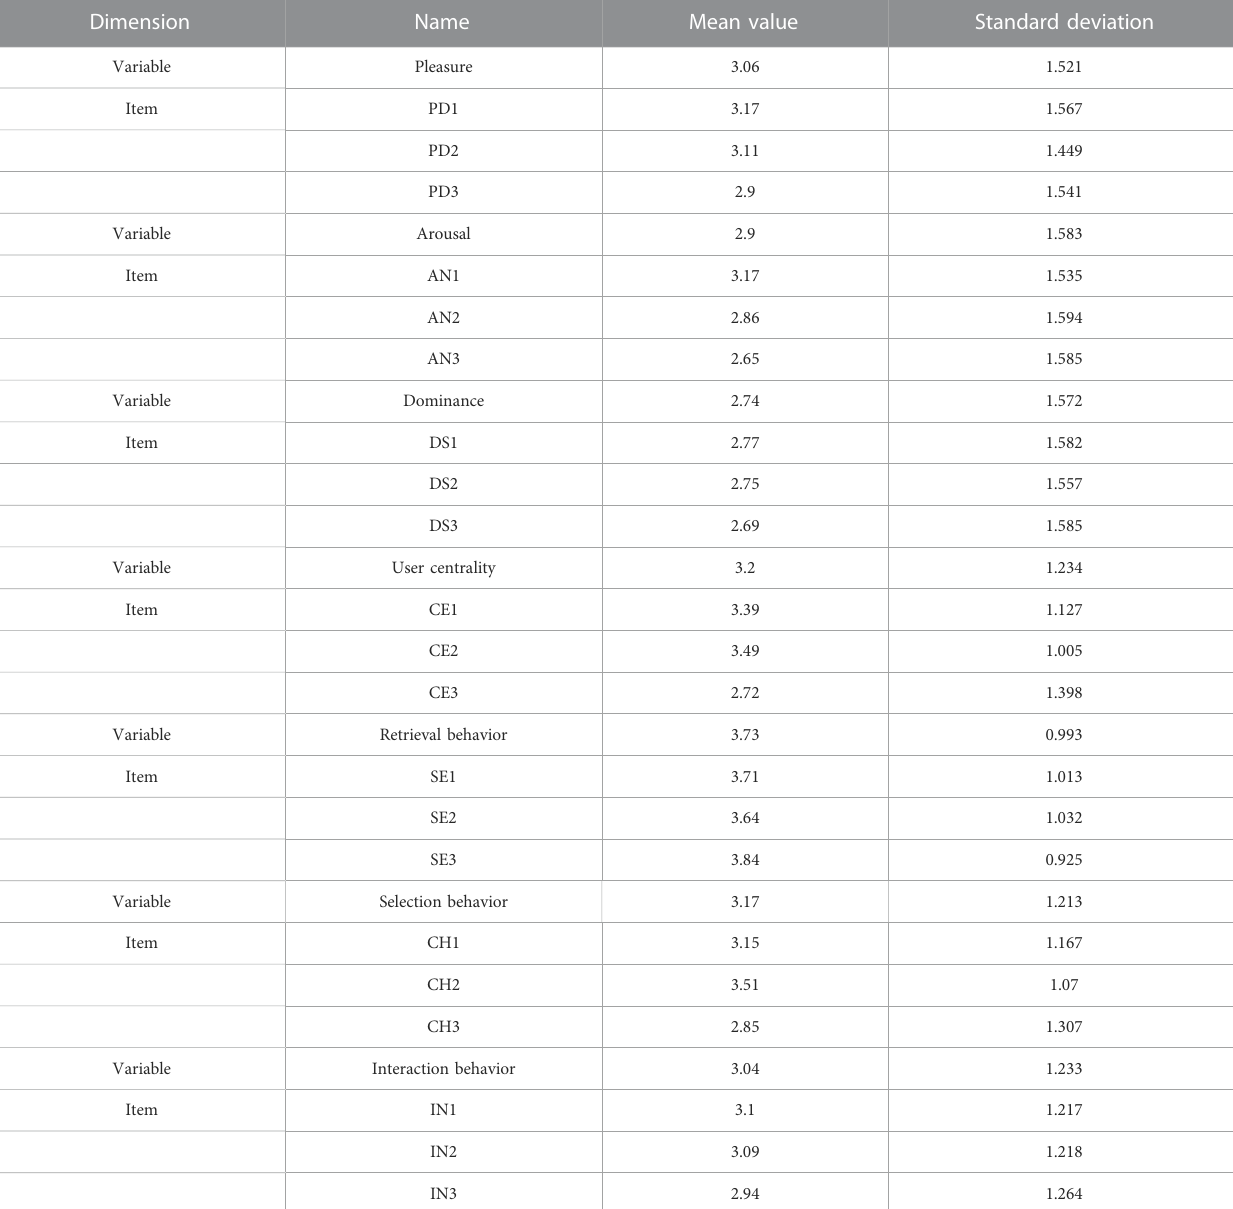
TABLE 5 Descriptive statistics of online knowledge community user behavior